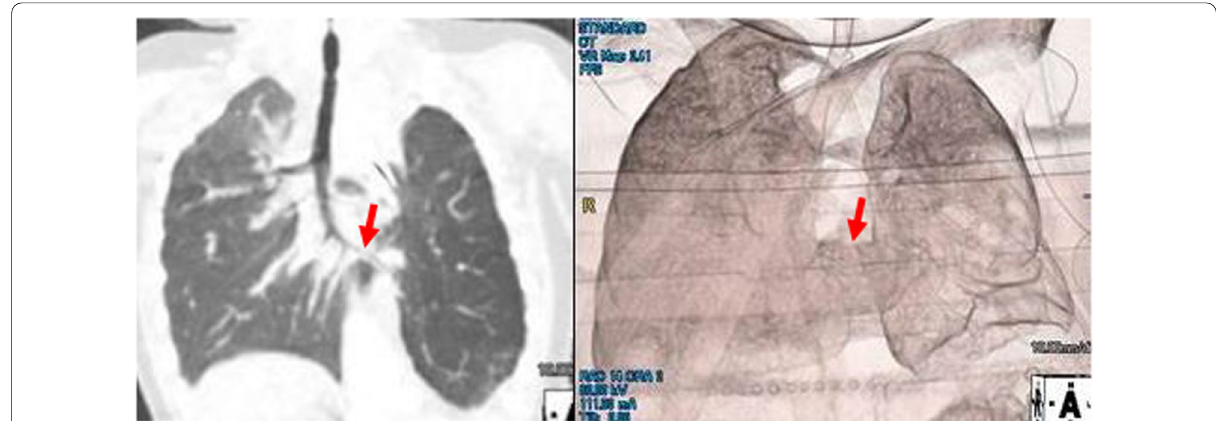
Fig. 5 A 4-month-old chest CT image showed no left lung or trachea, and the right lung remained hernia from the dorsal side of the heart into the left thoracic cavity (arrows)